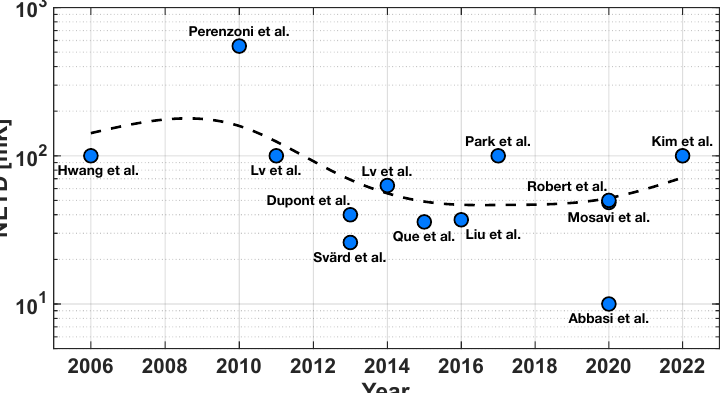
Figure 4. NETD trend of the main micro-bolometer works of the last 17 years